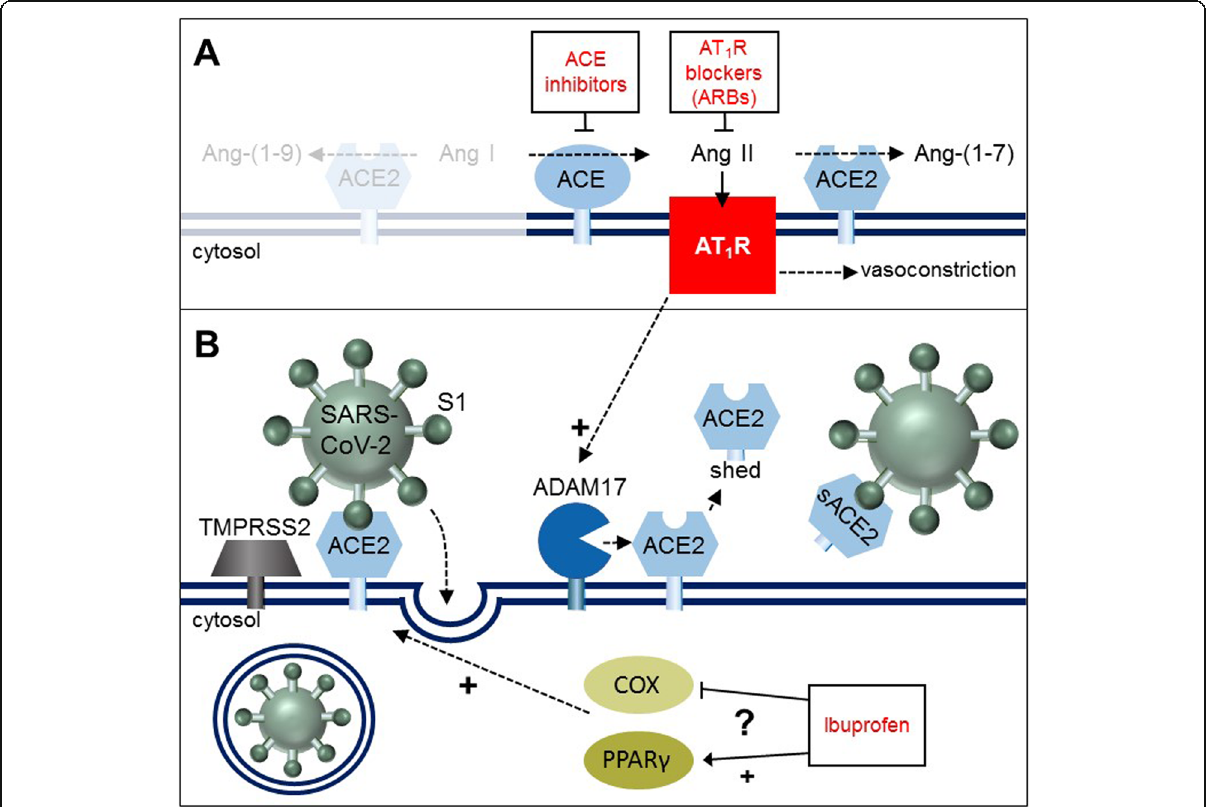
Fig. 1 The carboxypeptidase angiotensin-converting enzyme 2 (ACE2) converts angiotensin (Ang) I into Ang-(1 – 9) and Ang II into Ang-(1 – 7) and (panel a ), yet is not blocked by ACE inhibitors, which prevent the conversion of Ang I to Ang II. As depicted in (panel b ), ACE2 also binds and internalizes SARS-Cov-2, after priming by the serine protease transmembrane protease, serine 2 (TMPRSS2). Shedding of membrane-bound ACE2 by a disintegrin and metalloprotease 17 (ADAM17) results in the occurrence of soluble (s) ACE2, which can no longer mediate SARS-Cov-2 entry, and which might even prevent such entry by keeping the virus in solution. Ang II, via its type 1 receptor (AT 1 R), upregulates ADAM17, and AT 1 R blockers (ARBs) would prevent this. Ibuprofen has been suggested to increase ACE2, possibly via inhibition of cyclooxygenases (COXs) and activation of Peroxisome Proliferator-Activated Receptor gamma (PPAR- γ ). Redrawn after